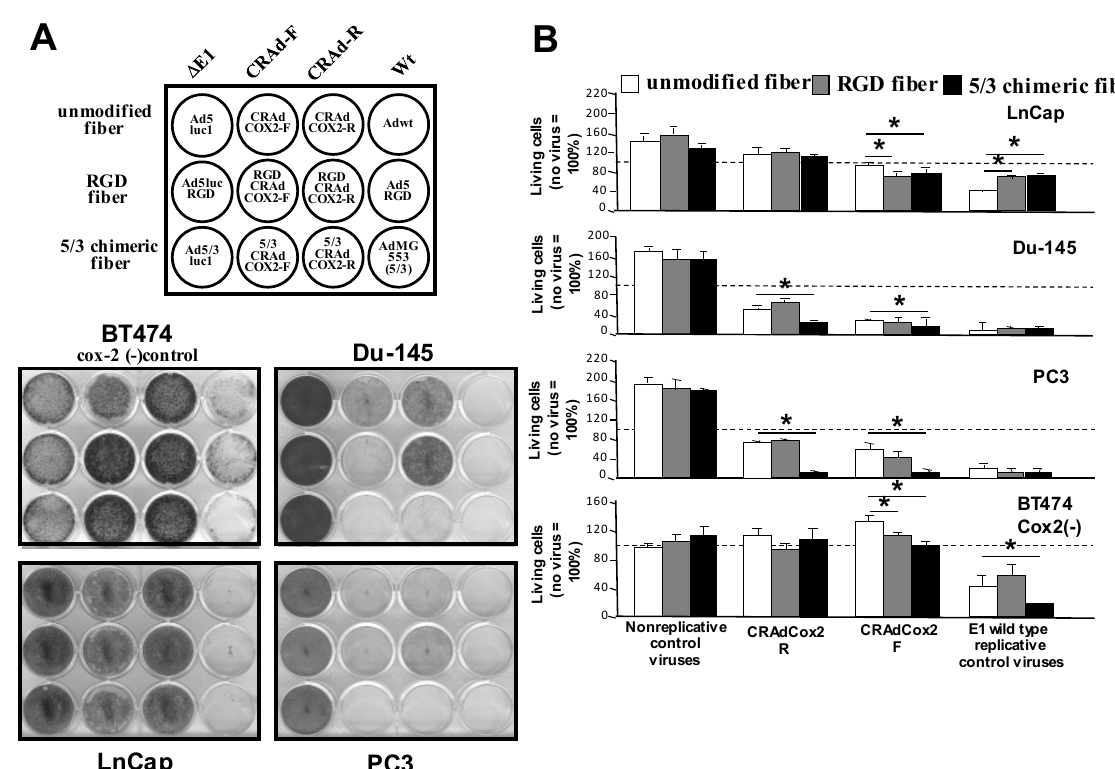
Figure 3. In vitro cytocidal effect of infectivity-enhanced, COX-2 CRAds in prostate cancer cell lines. ( A ) Crystal violet assay. Human prostate cancer cells (LnCap, Du-145, PC3), and COX-2 control cells (A549 and BT 474) were infected with CRAds at an MOI of 1 vp/cell. After 12 (Du-145, PC3) or 8 days (LnCap), the adenoviral cytotoxicity was analyzed by crystal violet staining. In prostate cancer cell lines, COX-2 CRAd showed a significant cytocidal effect in COX-2-positive Du-145 and PC3 cell lines, while it showed no significant effect on BT474 (COX-2-negative control cells) and LnCap (COX-2-negative) prostate cancer cells. CRAds with the left to right-direction E1 expression cassette (CRAdCox2F, RGDCRAdCox2F, 5/3CRAdCox2F) exhibited stronger oncolytic effect than CRAds with the reverse-direction cassette (CRAdCox2R, RGDCRAdCox2R, 5/3CRAdCox2R). The cytotoxicity of CRAds with different fibers was similar to that of the corresponding replicative control viruses containing the wild-type early genes (Ad5Wt, RGDWt, AdMG553). The nonreplicative controls (Ad5Luc1, RGDAd5Luc1, 5/3Ad5Luc1) did not cause any oncolysis. Data are representative samples from at least three experiments performed on each cell line. ( B ) Quantitative in vitro cytotoxicity assay. Human prostate cancer cells (LnCap, Du-145, PC3), COX-2-positive A549 cells, and COX-2-negative BT474 cells were infected with Ad vectors at 1.0 vp/cell. The cells were incubated for 18 days (14 days for LnCap), and the number of surviving cells was analyzed by a colorimetric method. All COX-2-based CRAds demonstrated oncolytic killing in CRPC cells (Du-145 and PC3) while no cytocidal effect was observed in the COX-2-negative control (BT474) and the COX-2-negative prostate cancer cell line (LnCap). In the Du-145 cell line, CRAdCox2R with the 5/3 modification showed an augmented cytocidal effect compared to fiber-unmodified and RGD-modified counterparts. In the PC3 cell line, CRAds with the 5/3 modification (F and R) were stronger than their fiber-unmodified and RGD-modified counterparts. * p <